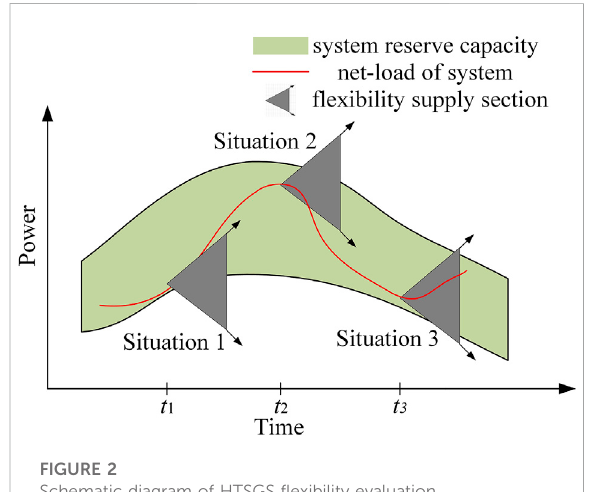
FIGURE 2 Schematic diagram of HTSGS fl exibility